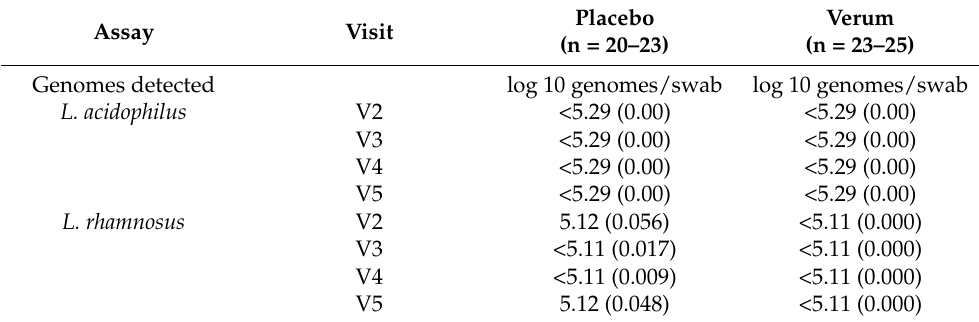
Table 5. Vaginal colonisation of Lactobacillus acidophilus and Lacticaseibacillus rhamnosus at species level shown as mean (SD) log 10 genomes/swab. The limit of detection (LOD) values were 5.29 log 10 genomes/swab and 5.11 log 10 genomes/swab for L. acidophilus and L. rhamnosus , respectively. V, Visit; V2, baseline visit; V3, after one week of intervention; V4, after two weeks of intervention; V5, after a one-week follow-up.